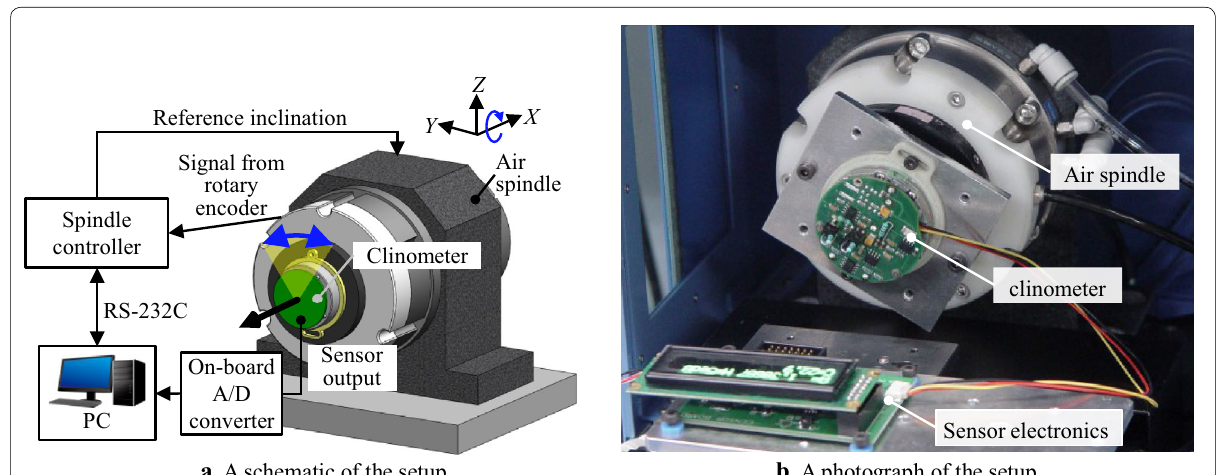
clinometerAir spindle